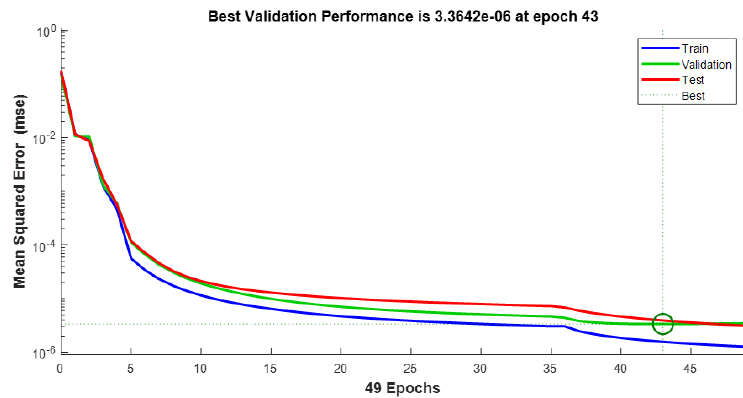
Figure 7. MSE of first step of ANN.